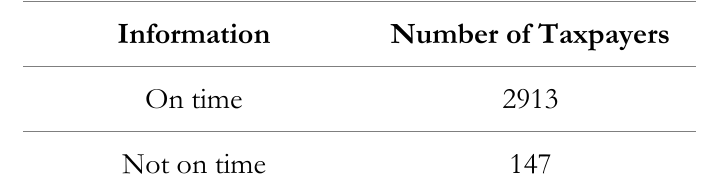
Table 1. Number of Park ing Taxpayers Who Reported and Payed ‘On Time’